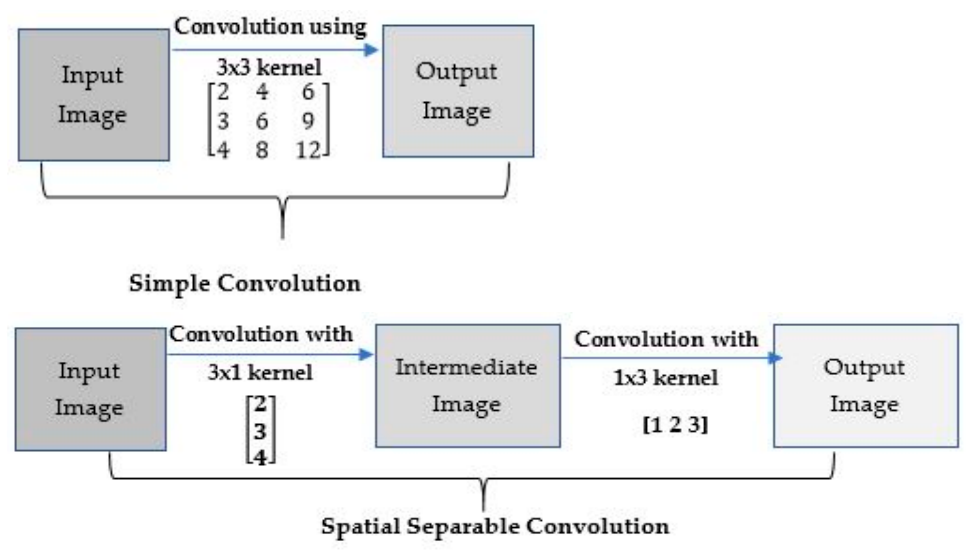
Figure 5. Simple and Spatial Separable Convolution.